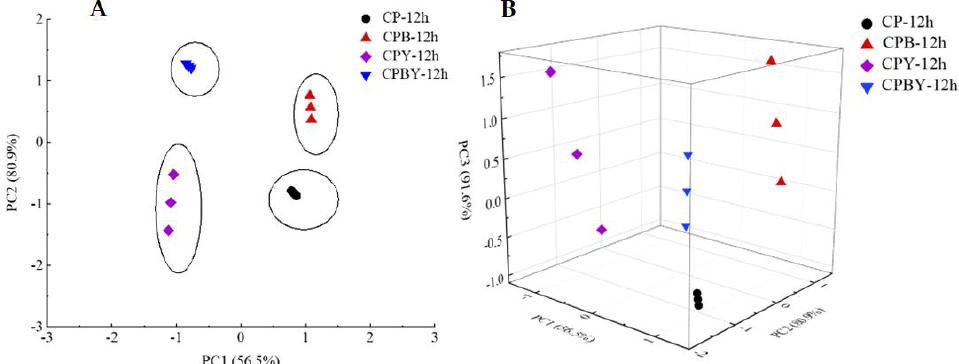
Figure 5. PCA scatter plots (2D and 3D) of four groups of fermented specimens. ( A ): two-dimension; ( B ): three- dimension. CP−12 h, fermented chickpea milk; CPB−12 h, fermented chickpea milk with ( B ): three-dimension. CP-12 h, fermented chickpea milk; CPB-12 h, fermented chickpea milk with papain treatment; CPY−12 h, fermented chickpea milk with yam addition; CPBY−12 h, fermented papain treatment; CPY-12 h, fermented chickpea milk with yam addition; CPBY-12 h, fermented chickpea milk with papain treatment plus yam addition. chickpea milk with papain treatment plus yam